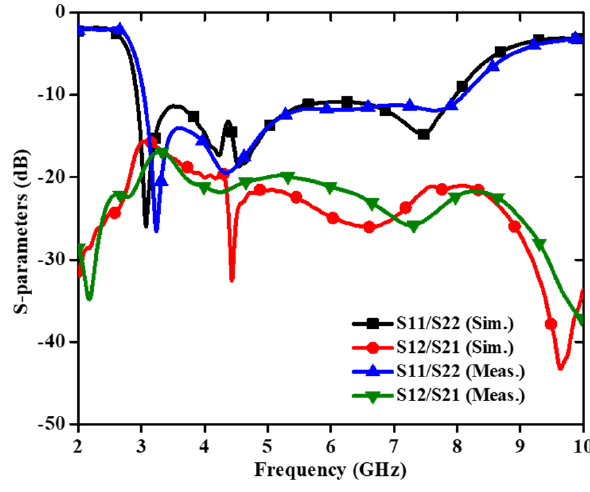
Figure 18. Prototype of circularly polarized MIMO antenna [71].